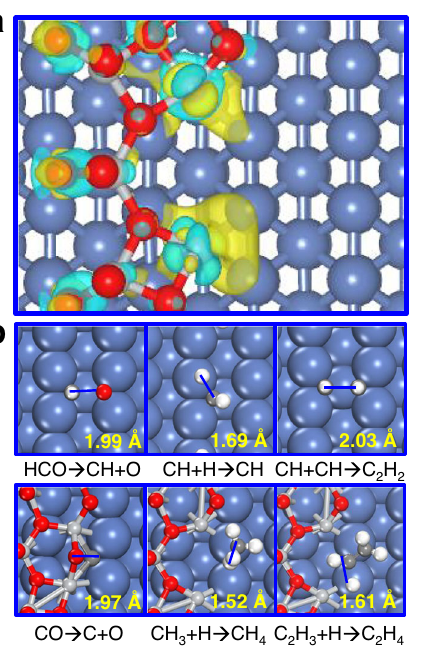
Fig.5|DFToptimizedstructuresandreactionmechanismstudies.a Differential charge densities of Ti 6 O 11 /Ni(110) surface. The light blue and yellow contours (isosurface=0.006e/Å 3 )representthechargedepletionandchargeaccumulation, respectively. b Key transition states con fi gurations for CO hydrogenation towards CH 4 and C 2 H 6 productsoverNi(110)(Toppanel)andTi 6 O 11 /Ni(110)(Bottom panel) surfaces.The solid blue line is drawn to signifythebond dissociationorformation. ThebonddistancesatthetransitionstatesforCOhydrogenationareindicatedinÅ.